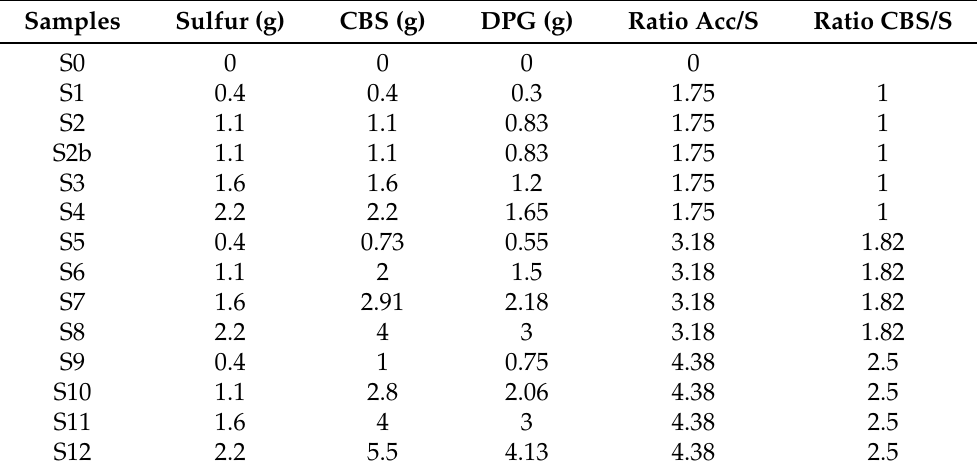
Table 1. List of the SBR samples. CBS and DPG are accelerators. All amounts are expressed in g and are relative to 137.5 g of oil-extended SBR.